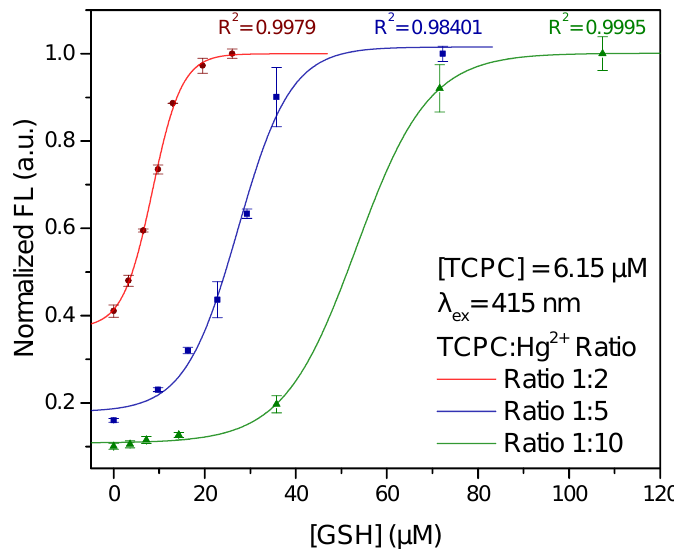
Figure 5. Fluorescence intensity changes when a different amount of GSH is added to (red) 1:2, (blue) 1:5, and (green) 1:10 molar ratio of TCPC-Hg 2+ complex aqueous solutions at pH 7.4. The error bars were calculated from the standard deviation of three independent